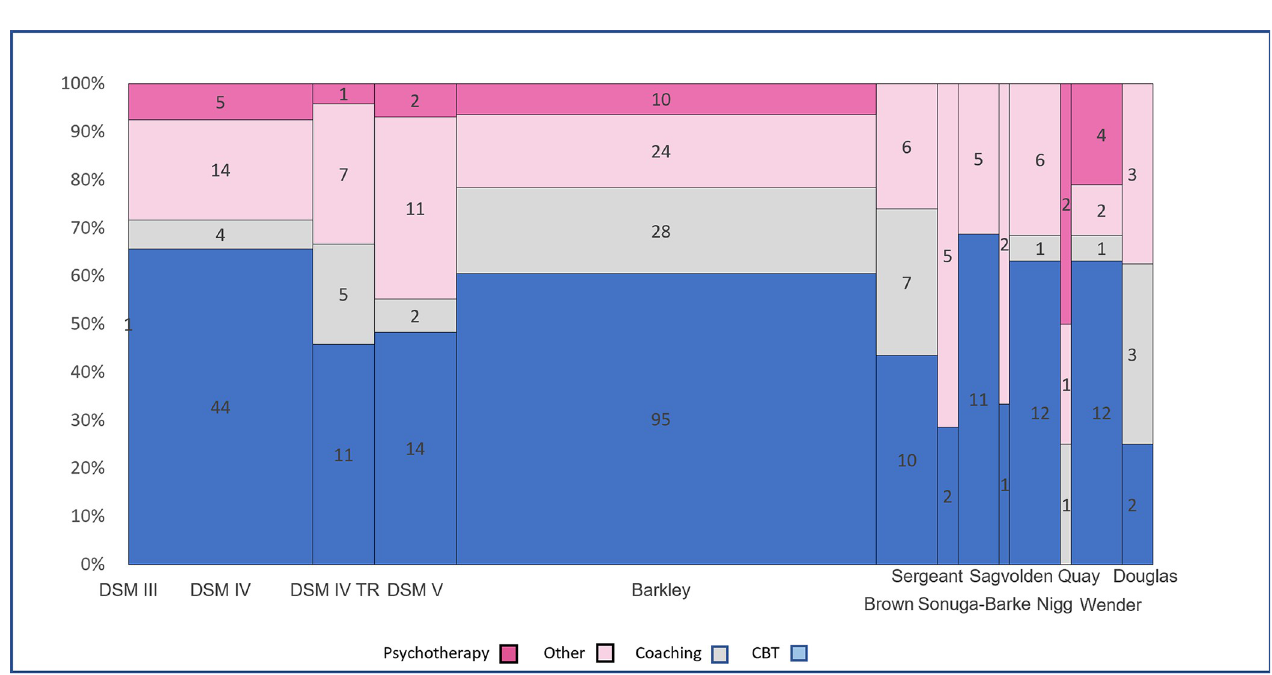
Fig 2. ADHD characterisations cited in intervention category.